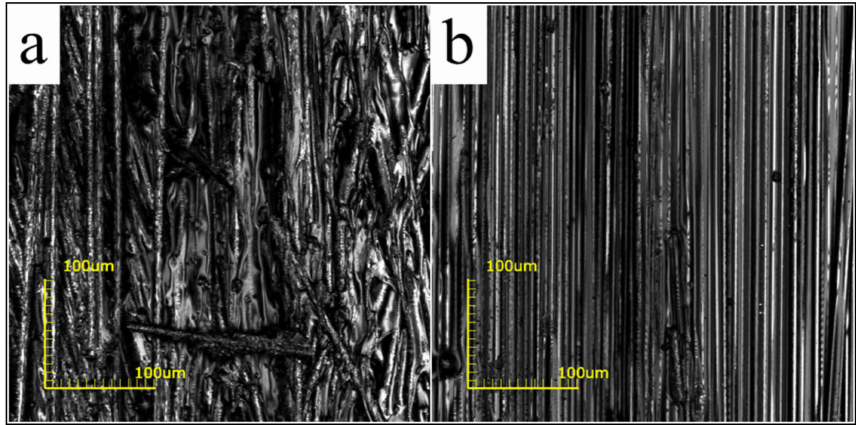
Figure 8. The surface of the filaments impregnated by ( a ) 0.6 mm and ( b ) 1.0 mm diameter